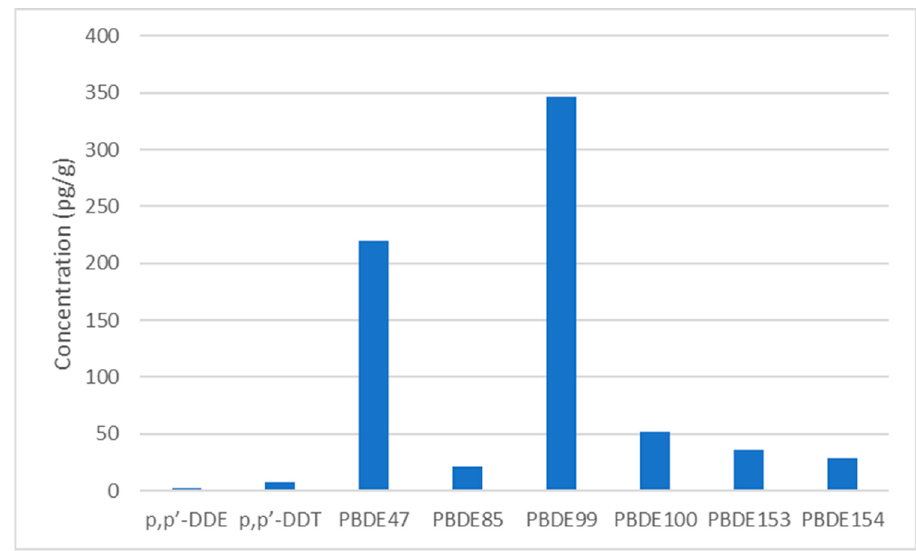
Figure 2. Median concentrations of the most prevalent persistent organic pollutants detected in Atlanta house dust, 2016–2019.